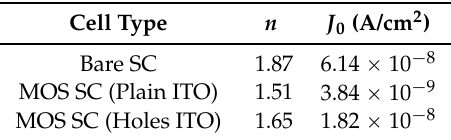
Figure 1. Dark I-V characteristics of bare cell and cells with MOS structure (using plain and perforated electrodes) at 25 °C. Table 1. Ideality factor ( n ) and reverse saturation current density ( J 0 ) extracted from measured I-V curves at 25 °C.